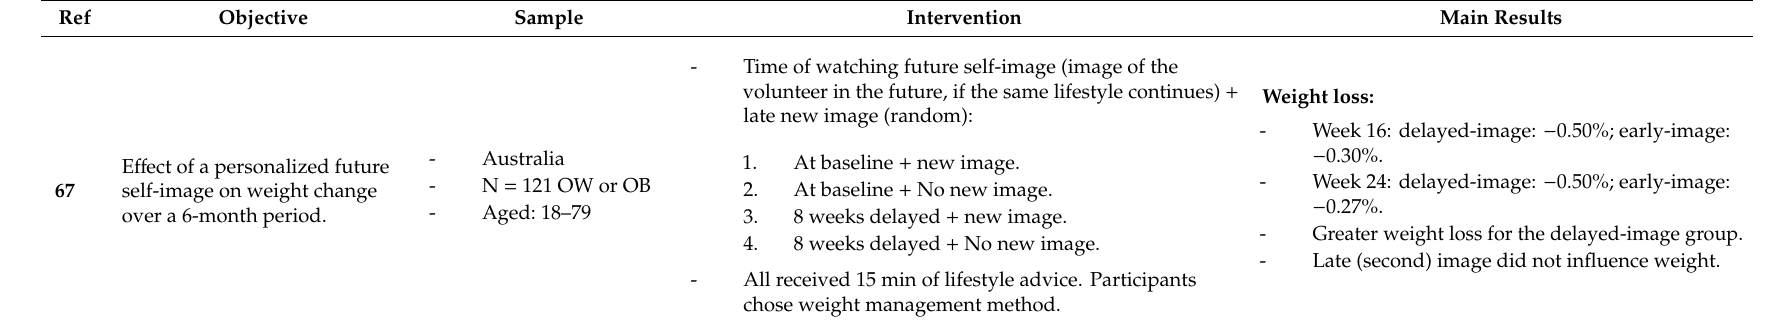
Table 2. Intervention